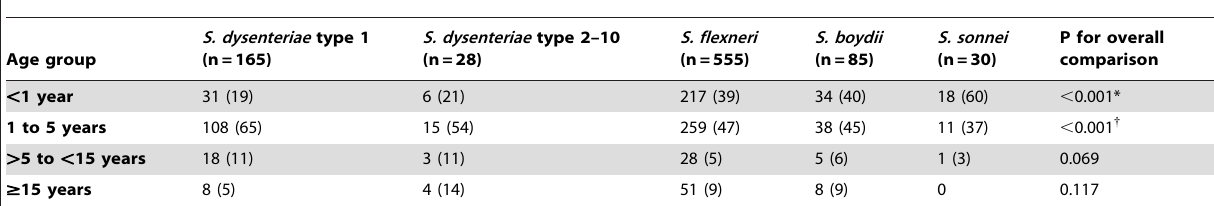
Table 1. Isolation of Shigella Species by Age Group of Patients Admitted to the Dhaka Hospital of the ICDDR, B.